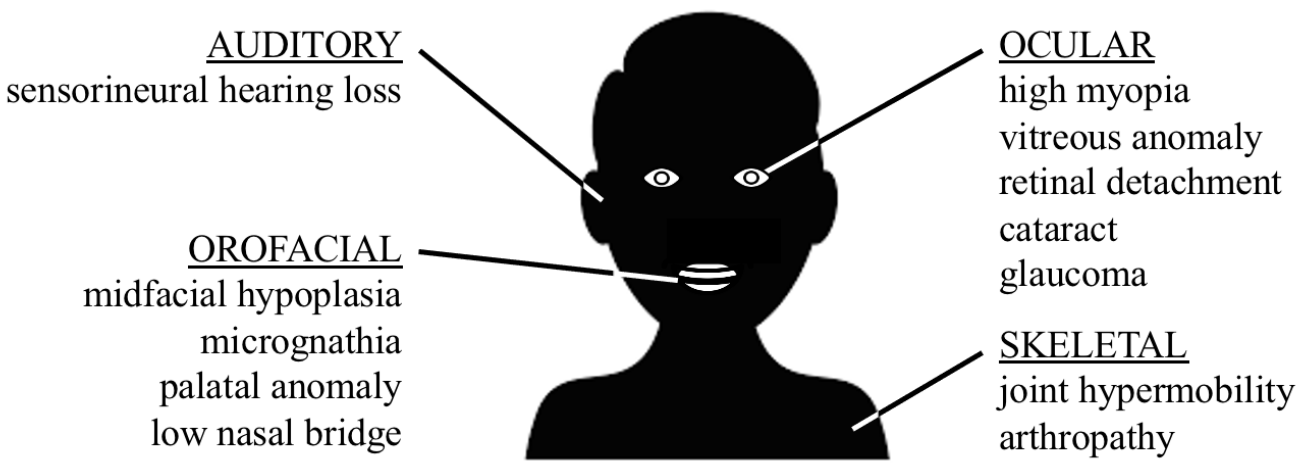
Figure 1. Overview of the four body systems involved in Stickler syndrome, including the main symptoms. Eventually, part of the auditory heterogeneity seen in Stickler syndrome was resolved by the discovery of different genes involved in the syndrome. The first mutation in a Stickler syndrome family was found in the COL2A1 gene in 1991 [5]. Some years later, disease-causing mutations in the COL11A1 and COL11A2 gene could also be associated with a Stickler syndrome phenotype [6,7]. In addition to hearing loss, another clinically distinguishing factor between these three genes is the vitreous appearance, seen on slit lamp biomicroscopy. A membranous type of congenital vitreous anomaly is mainly seen in type 1 Stickler syndrome (STL1, COL2A1 ), whereas a beaded vitreous anomaly is often associated with type 2 Stickler syndrome (STL2, COL11A1 ). In type 3 Stickler syndrome (STL3, COL11A2 ), no ocular symptoms are observed as Col11a2 is not expressed in the eyes [8]. To our experience, skeletal and orofacial symptoms do not differ considerably among the three main types of Stickler syndrome. Additionally, each of the rarer types of Stickler syndrome have their own typical appearance which is summarized in Table 1. Table 1. Overview of the different types/genes of Stickler syndrome with the main distinguishing features (partly based on [9,10], AD = autosomal dominant, AR = autosomal recessive). Type of Stickler Main Distinguishing Features